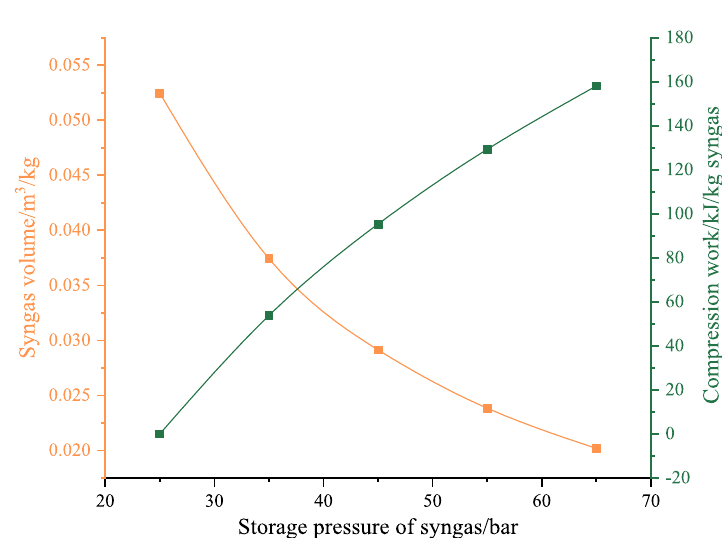
Fig. 6 Syngas volume and compression energy consumption under the different pressures (the storage temperature is 25 °C)